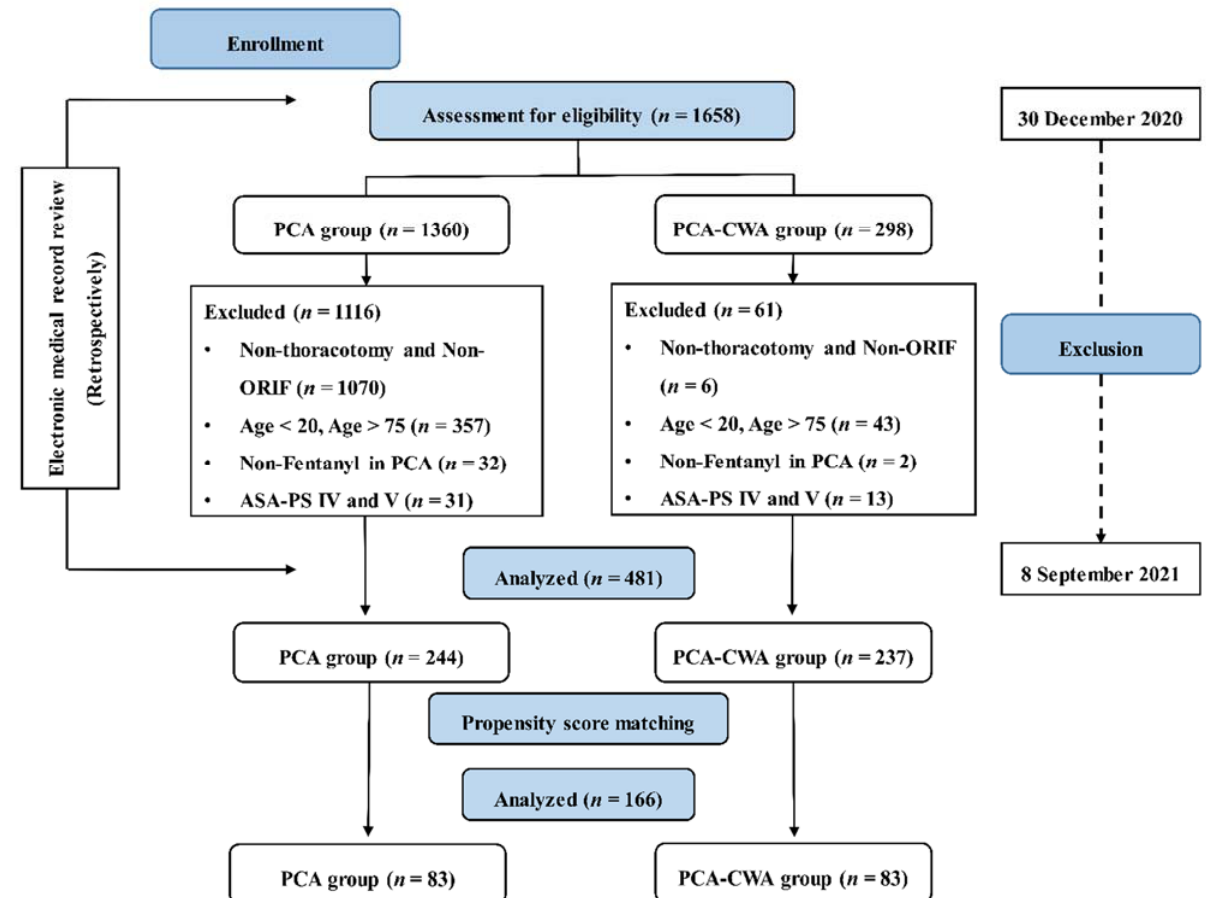
Figure 1. Flowchart of this study. ASA-PS, American Society of Anesthesiologists—Physical Status; ORIF, open reduction and internal fixation; PCA, intravenous patient-controlled analgesia. PCA group, group of patients who received postoperative intravenous PCA alone; PCA-CWA group, group of patients who received postoperative intravenous PCA and continuous wound infusion analgesia.